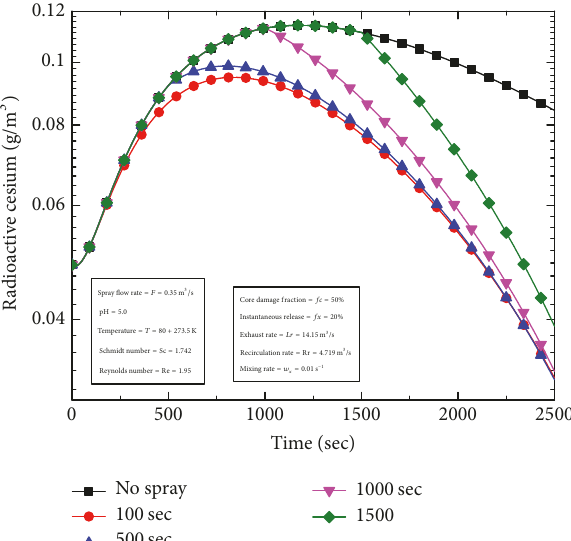
Figure 10: Cesium mass inventory with different spray activation time during in-vessel release phase with mixing rate 𝑤 푥 = 0.01s −1 .